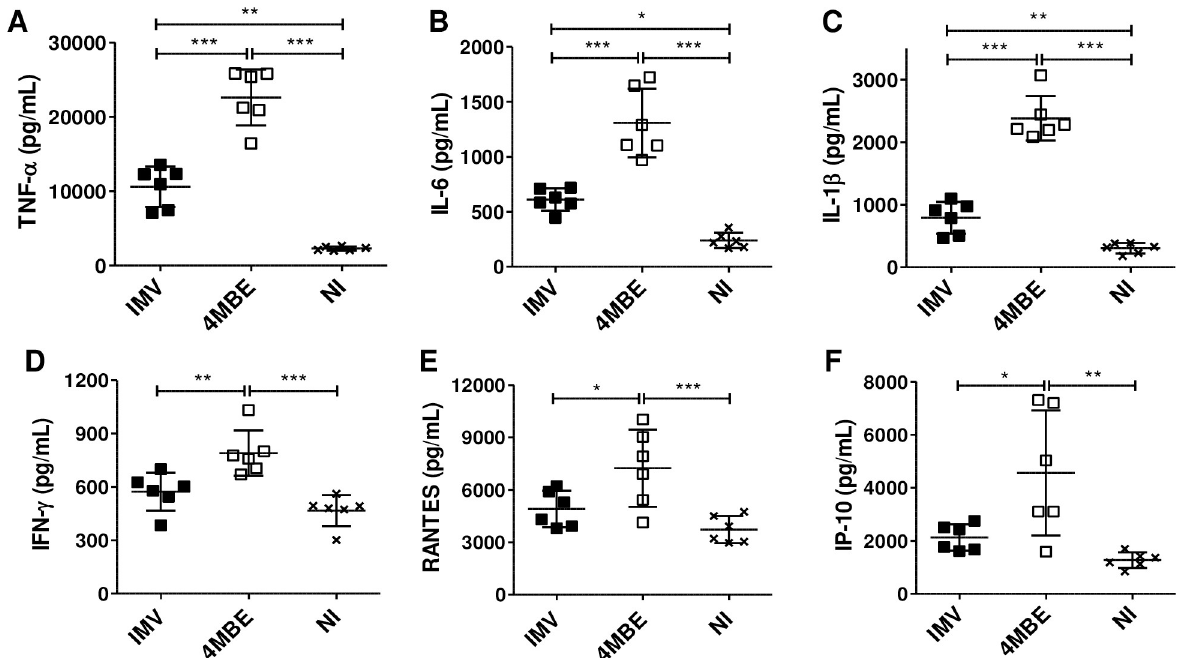
Fig 9. Macrophage inflammatory response is exacerbated upon infection by the 4MBE variant. Macrophages were infected by the IMV (black) or the 4MBE variant (white) at a MOI of 10:1 or not infected (NI, cross). (A) TNF- α , (B) IL-6, (C) IL-1 β , (D) IFN- γ , (E) RANTES (CCL5) and (F) Interferon gamma-induced protein 10 (IP-10) release in cell culture supernatant was evaluated by Luminex Multiplex assay at 24 hpi. Values for each condition are the mean ± SD of three independent experiments, analyzed in duplicate. Means were compared using Repeated Measures ANOVA followed by Bonferroni correction. � p < 0.05, �� p < 0.01, ��� p <